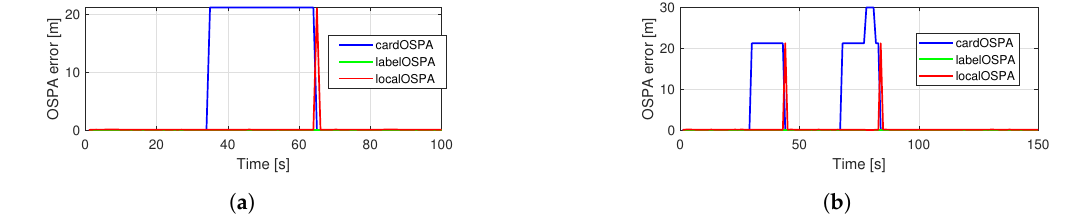
Figure 12. Performance of the basic filter in the simulated traffic scenarios with one ( a ) and two ( b ) observed vehicles.